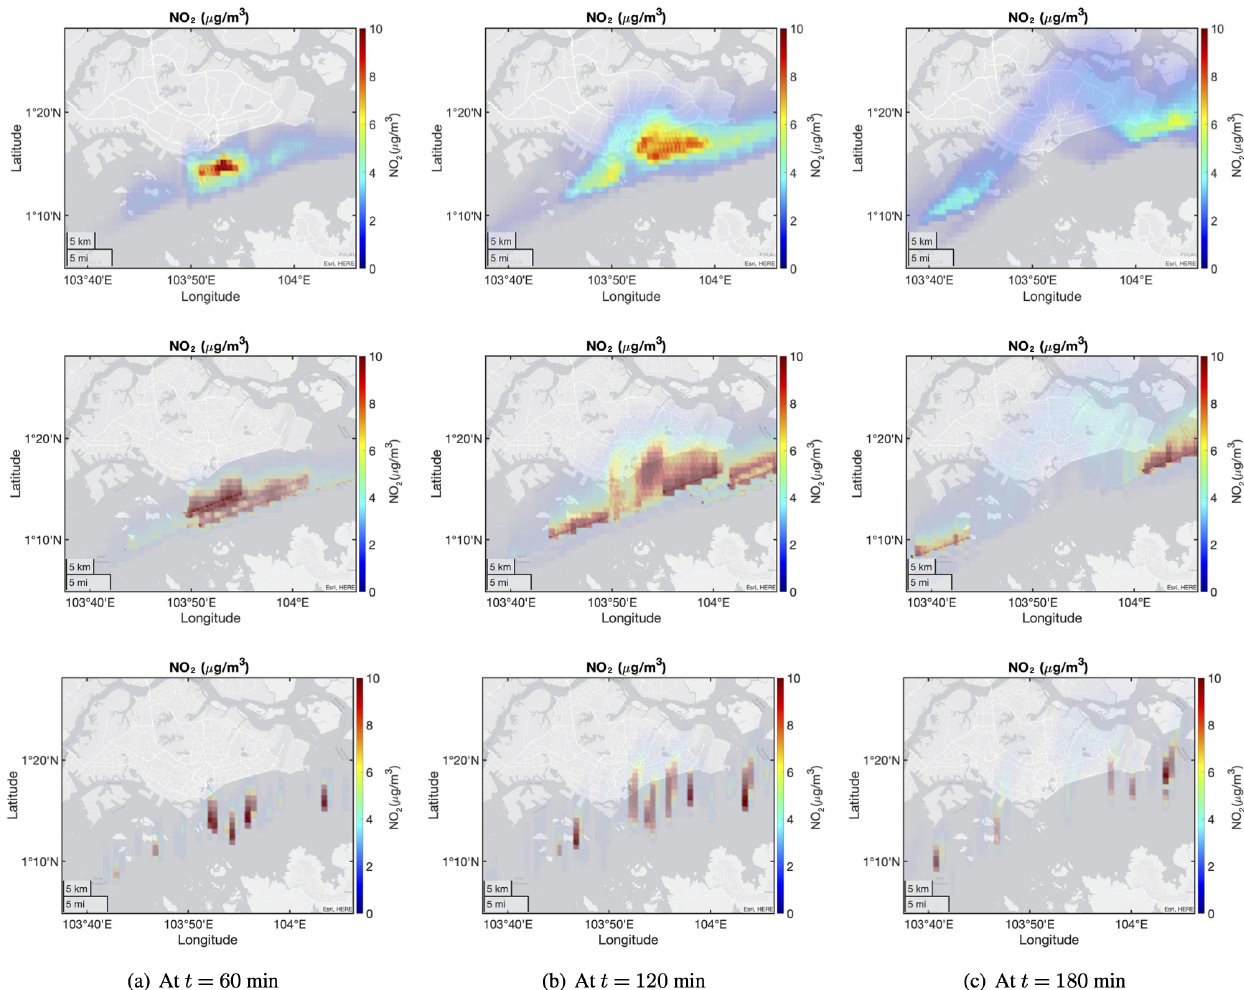
Figure 15. Hourly averaged NO 2 concentrations near the ground by using different emission models. Top row: MPS model (case 1); middle row: LS model (case 2); bottom row: FPS model (case 3).